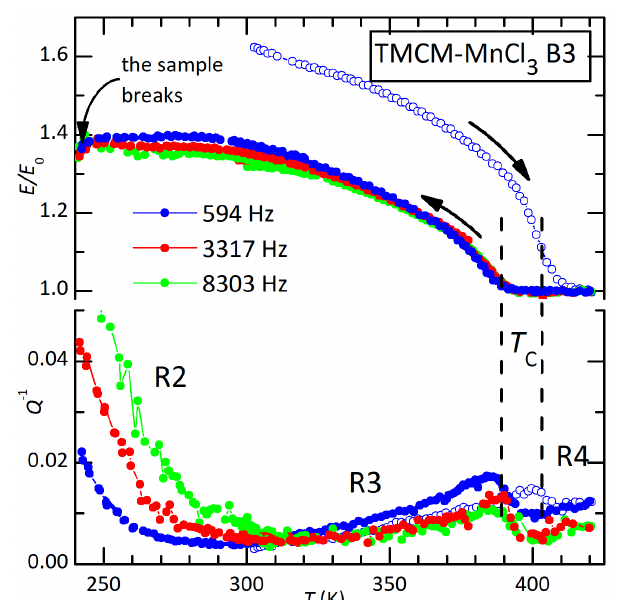
Figure 4. Normalised Young’s modulus E / E 0 = ( f / f 0 ) 2 and elastic energy loss coefficient Q − 1 of Sample B3 of TMCM-MnCl 3 measured during heating and subsequent cooling, exciting the 1st, 3rd, and 5th flexural modes, whose frequencies at a high temperature are indicated in the legend. The labels R n indicate the thermally activated relaxations that are observed also in the dielectric spectra.